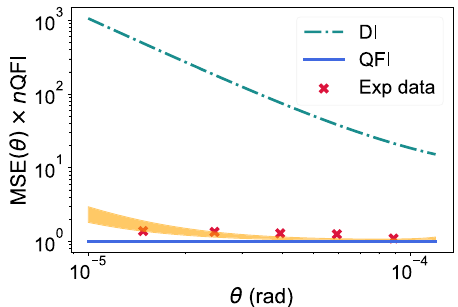
Fig. 7 | The mean squared error (MSE) of estimating the angular separation between two equally bright sources, normalised by the QFI, for different values of angular separation. The plot shows: (1) the normalised QFI, which is equal to 1 here, and is constant across the whole range of angular separations θ (blue solid line); (2) the MSE for shot-noise limited DI (teal dotted-dashed line); (3) the Fisher information for an interferometer with a visibility-phase factor ν cos ð α Þ between 0.965 and 0.985 (orange shaded region); (4) the experimentally achieved MSE (red